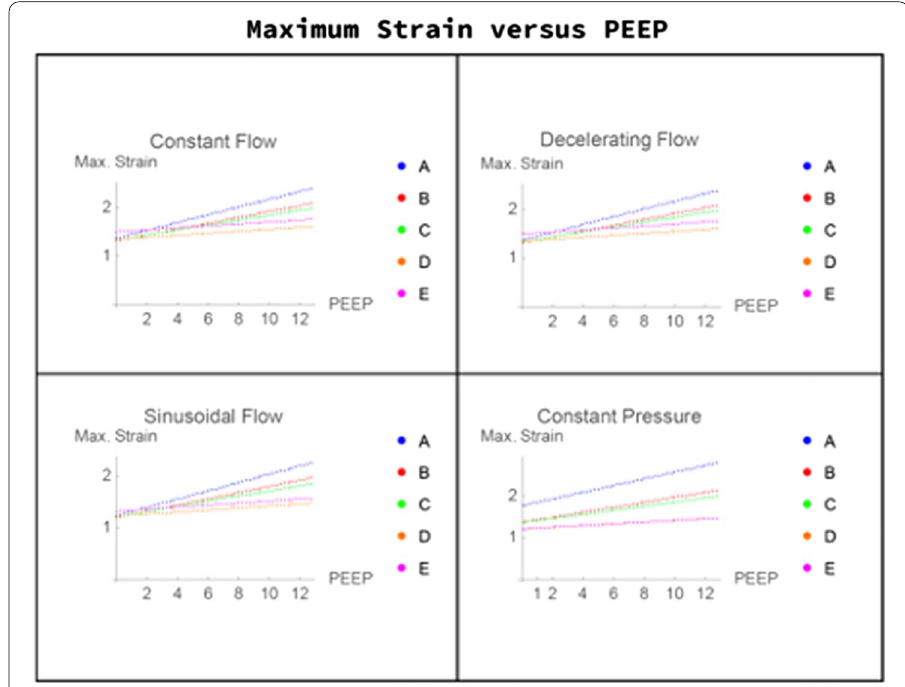
Fig. 5 Maximum compartmental strains as a function of PEEP for the four modes of ventilation. PEEP causes maximal strains to rise monotonically but to different degrees in all